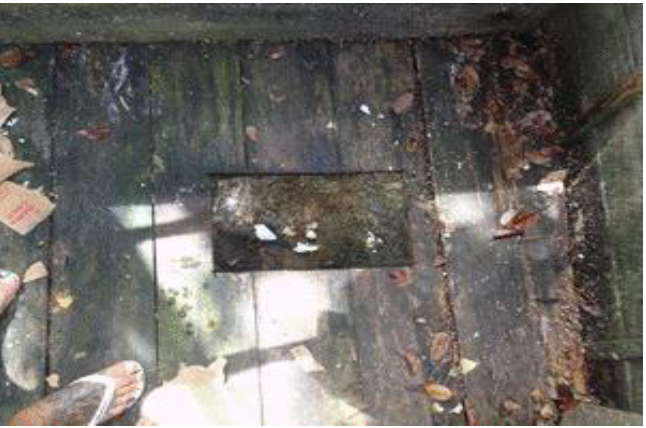
Figura 5: de Banheiro sem Tratamento – PAE Pacajaí I. Fonte: IATAM,